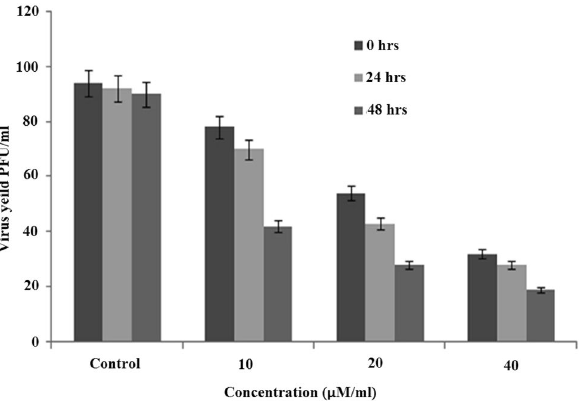
Figure 7. Post treatment reduction in DEN-2 viral yield with 4,7-dichloroquinoline at different time